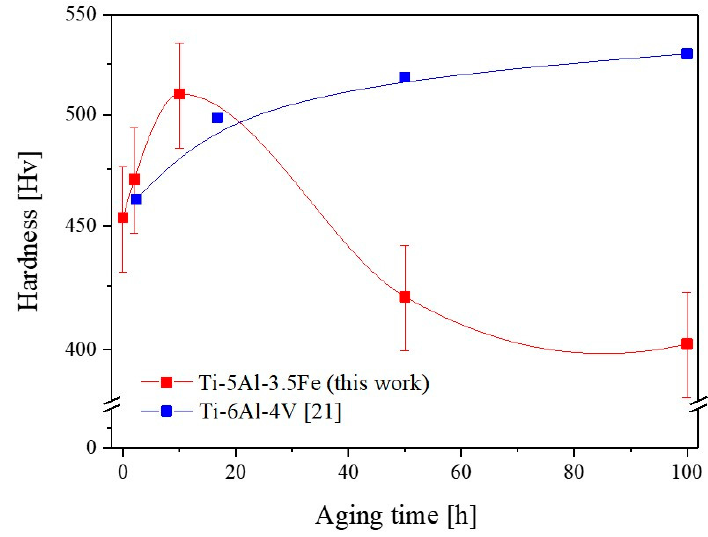
Figure 6. Variation in average hardness with aging time; the value at aging time = 0 h indicates the hardness for the initial material. Error bars indicate the standard deviations. A result of Ti-6Al-4V [21] is presented for comparison.